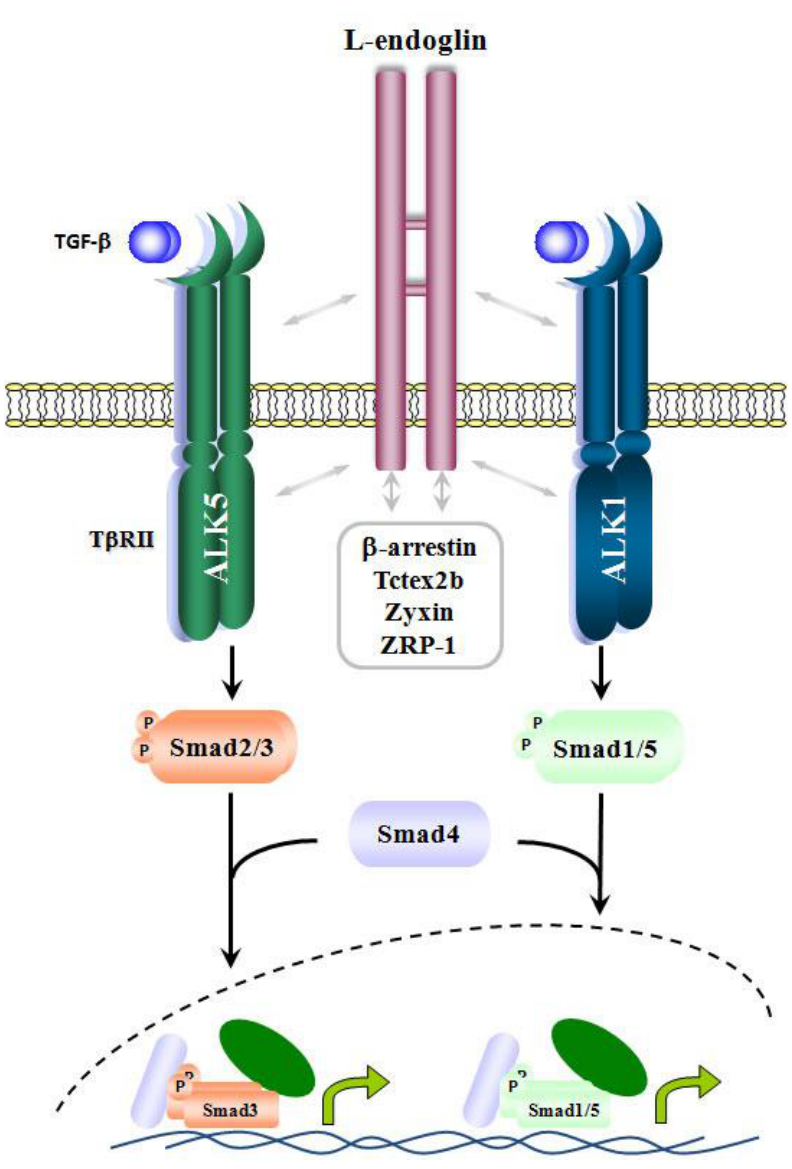
FIGURE 2 . Hypothetical model for endoglin regulation of TGF-β– dependent and –independent cell responses. Endoglin modulates TGF-β signaling by interacting with TβRI (ALK5 and ALK1) and TβRII through its extracellular and cytoplasmic domains. The endoglin cytoplasmic domain interacts with β-arrestin, Tctex2b, zyxin, and ZRP-1 proteins. Through these interactions, endoglin could mediate F-actin rearrangements, cell adhesion, and migration, as well as protein transport via endocytic